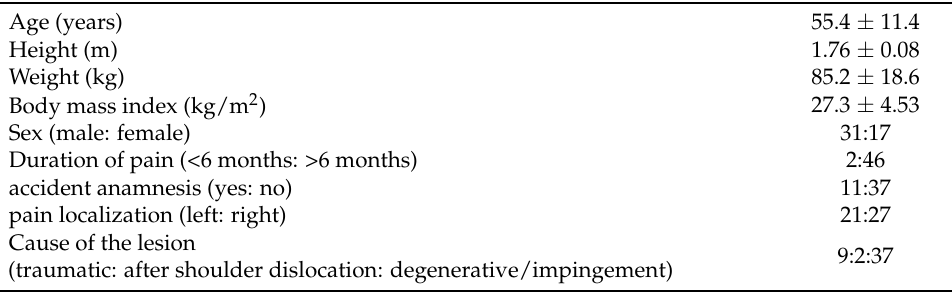
Table 1. Patient anthropometric and demographic data ( n =